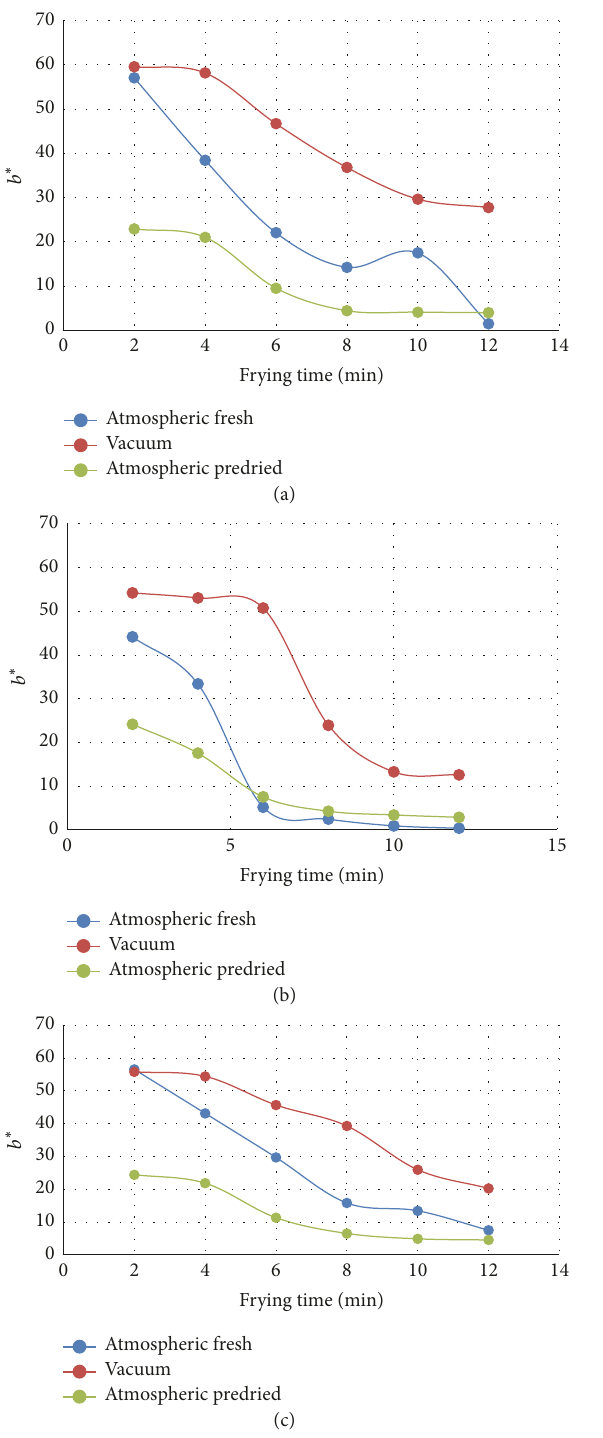
Figure 4: Effect of frying conditions on yellowness of yellow fleshed cassava chips (YFCC) at different equivalent thermal driving forces (ETDF) of (a) 60 ∘ C, (b) 70 ∘ C, and (c) 80 ∘ C.